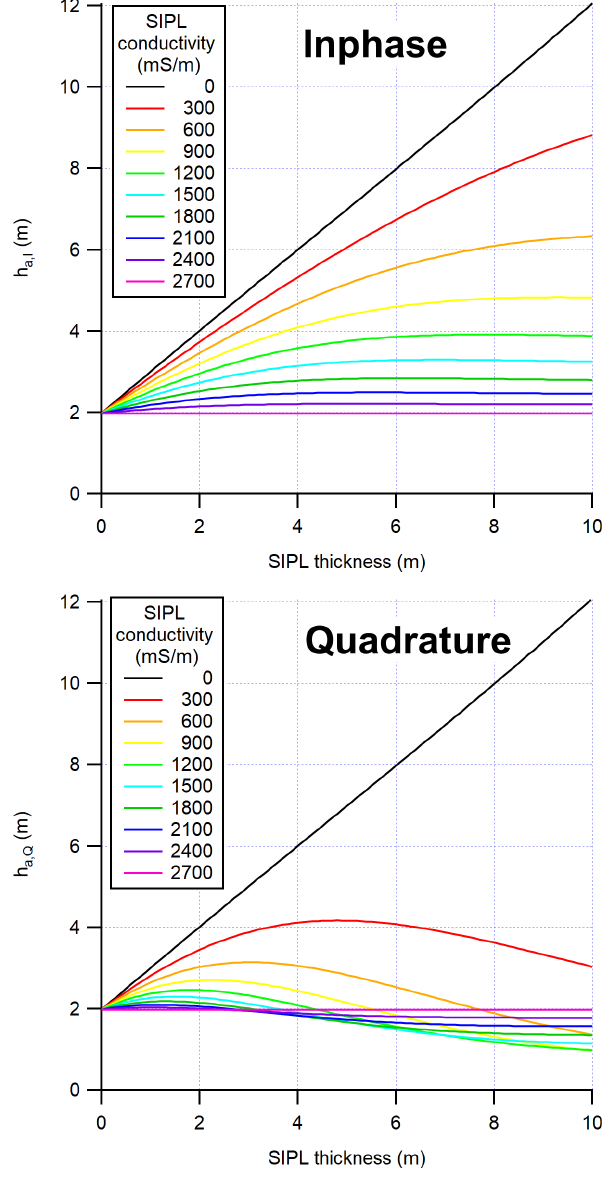
Figure 4. Apparent thicknesses resulting from applying simple negative-exponential equations like in Eq. (3a, b) to the I and Q curves in Fig.